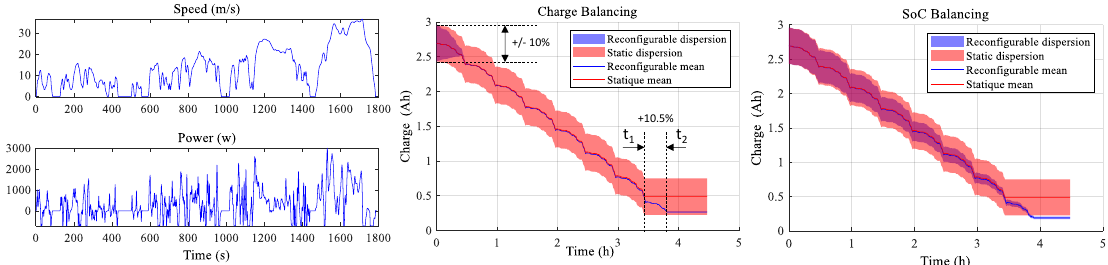
Figure 11. Comparison of charge dispersions between a static battery and a self-reconfiguring battery discharging with Worldwide harmonized Light vehicles Test Cycle (WLTC) vehicle cycles.